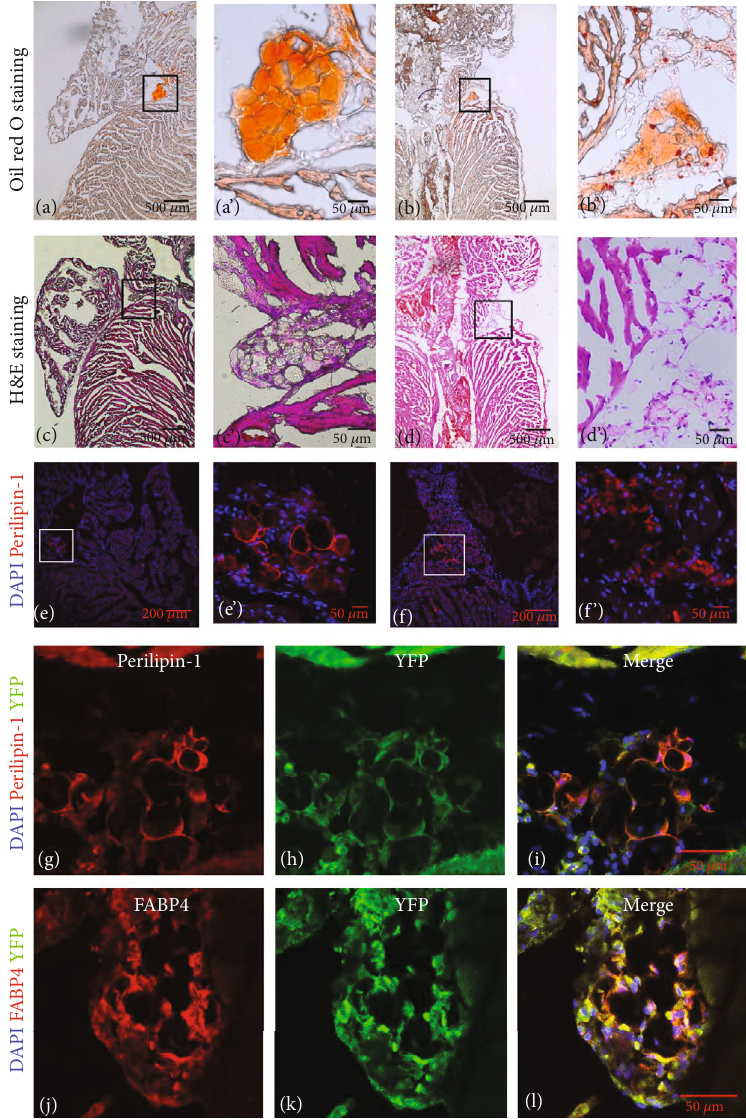
Figure 1: EAT located at the left and right atrial – ventricular groove in postnatal 8-week-old mouse hearts. (a, b) Oil red O staining showed that EAT located at the atrial – ventricular groove in mouse. The boxed regions were shown at higher magni fi cation in A ’ and B ’ . (c, d) H&E staining showed that EAT was present in the atrial – ventricular groove underneath the epicardium. The boxed regions were shown at higher magni fi cation in C ’ and D ’ . (e, f) Immuno fl uorescence staining for adipocyte marker perilipin-1 showed the epicardial adipocytes were present in the right and left atrial – ventricular groove. The boxed regions were shown at higher magni fi cation in E ’ and F ’ . (g – l) The genetic lineage tracing methods were used to trace the EPCs. Immuno fl uorescence staining for adipocyte markers perilipin-1 (red) and FABP4 (red) was partly colocalized with the lineage marker EYFP (green) in the same